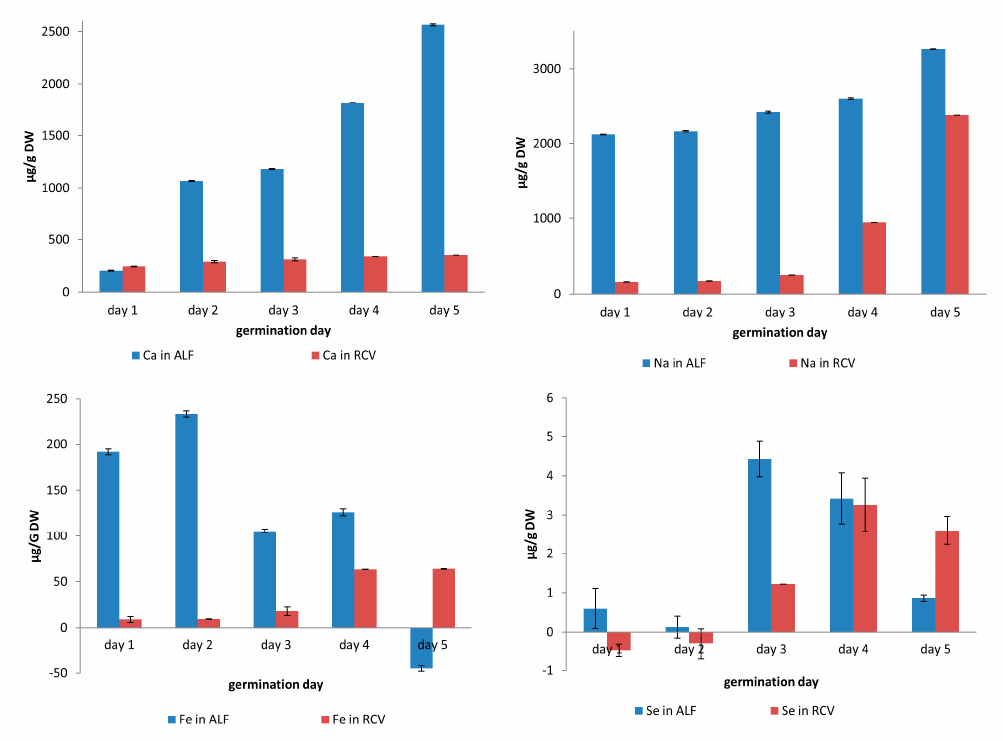
Figure 3. Relative change per day in Ca, Na, Fe, and Se content in sprouts of ALF and RCV during germination, compared to row seeds.